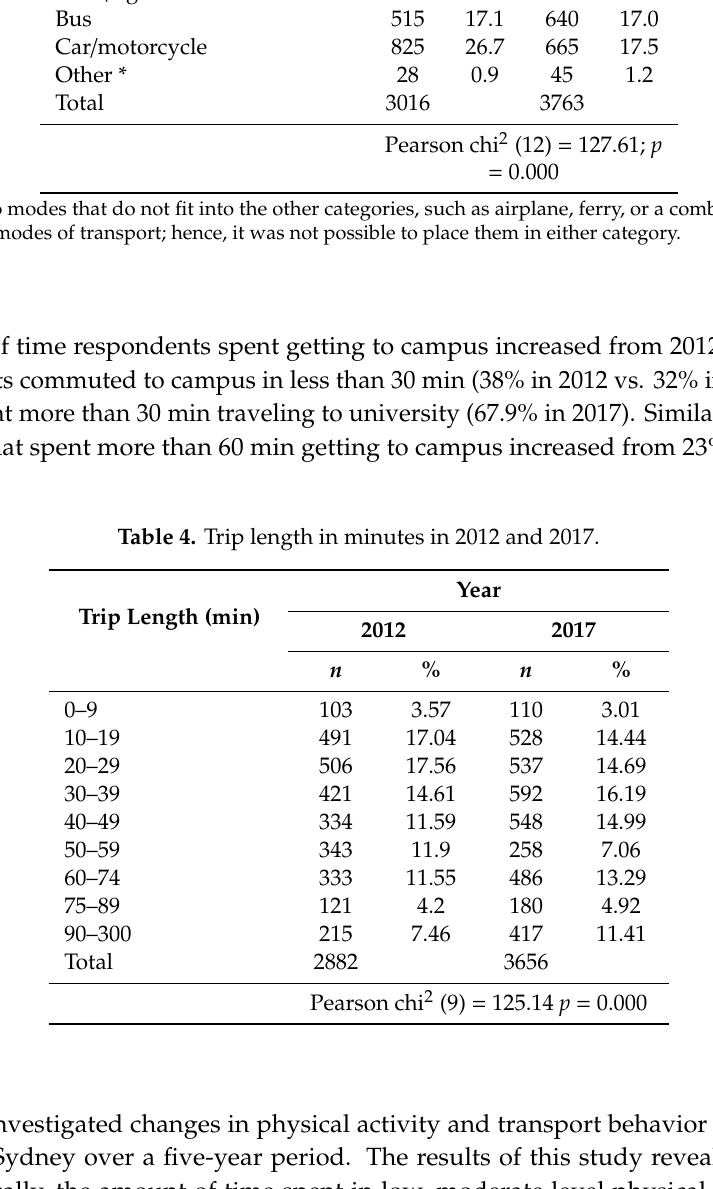
Main Mode of Travel to Uni